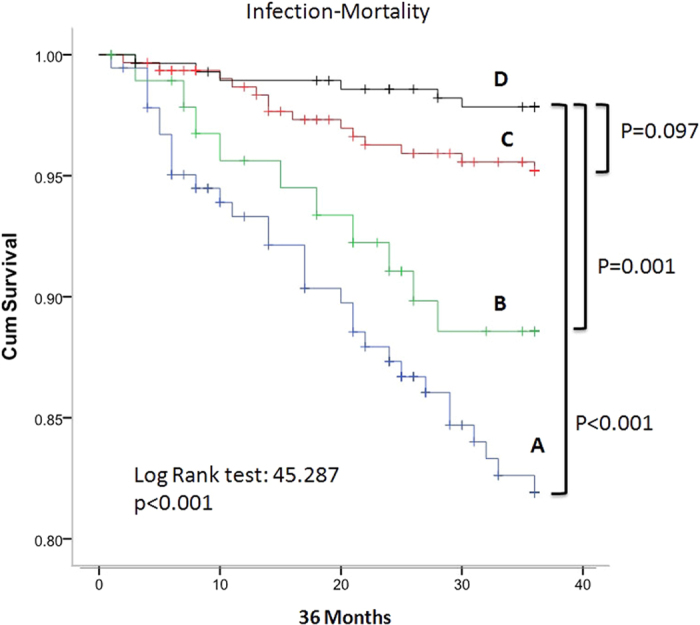
Cumulative survival rates based on infection related mortality and different groups of hemodialysis patients.(A–D) Group (A–D) patients.